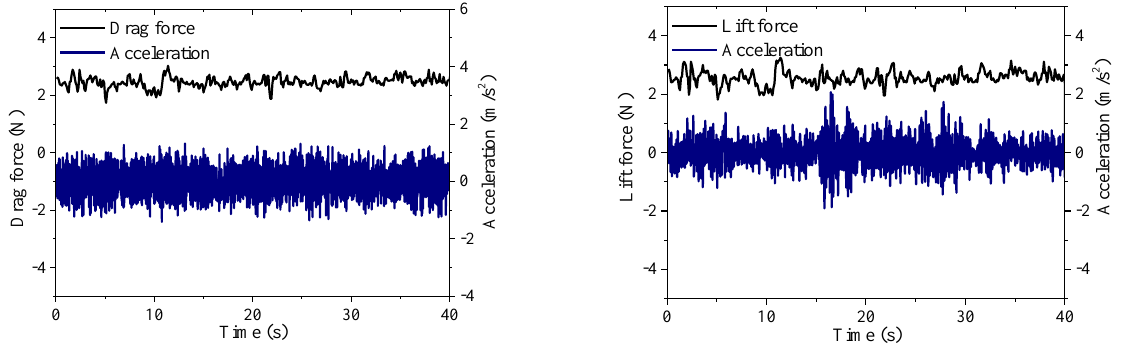
Figure 8. Time histories of aerodynamic forces (at wind attack angle of 30°) and vibration accelerations in the corresponding direction, with test conditions of expressway and no end plates.